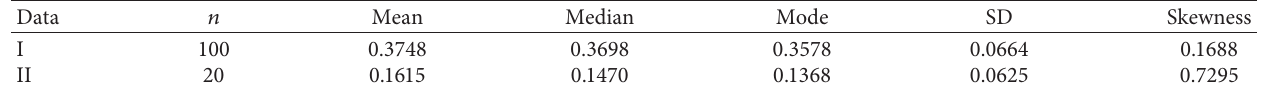
for dataset I and dataset II. py